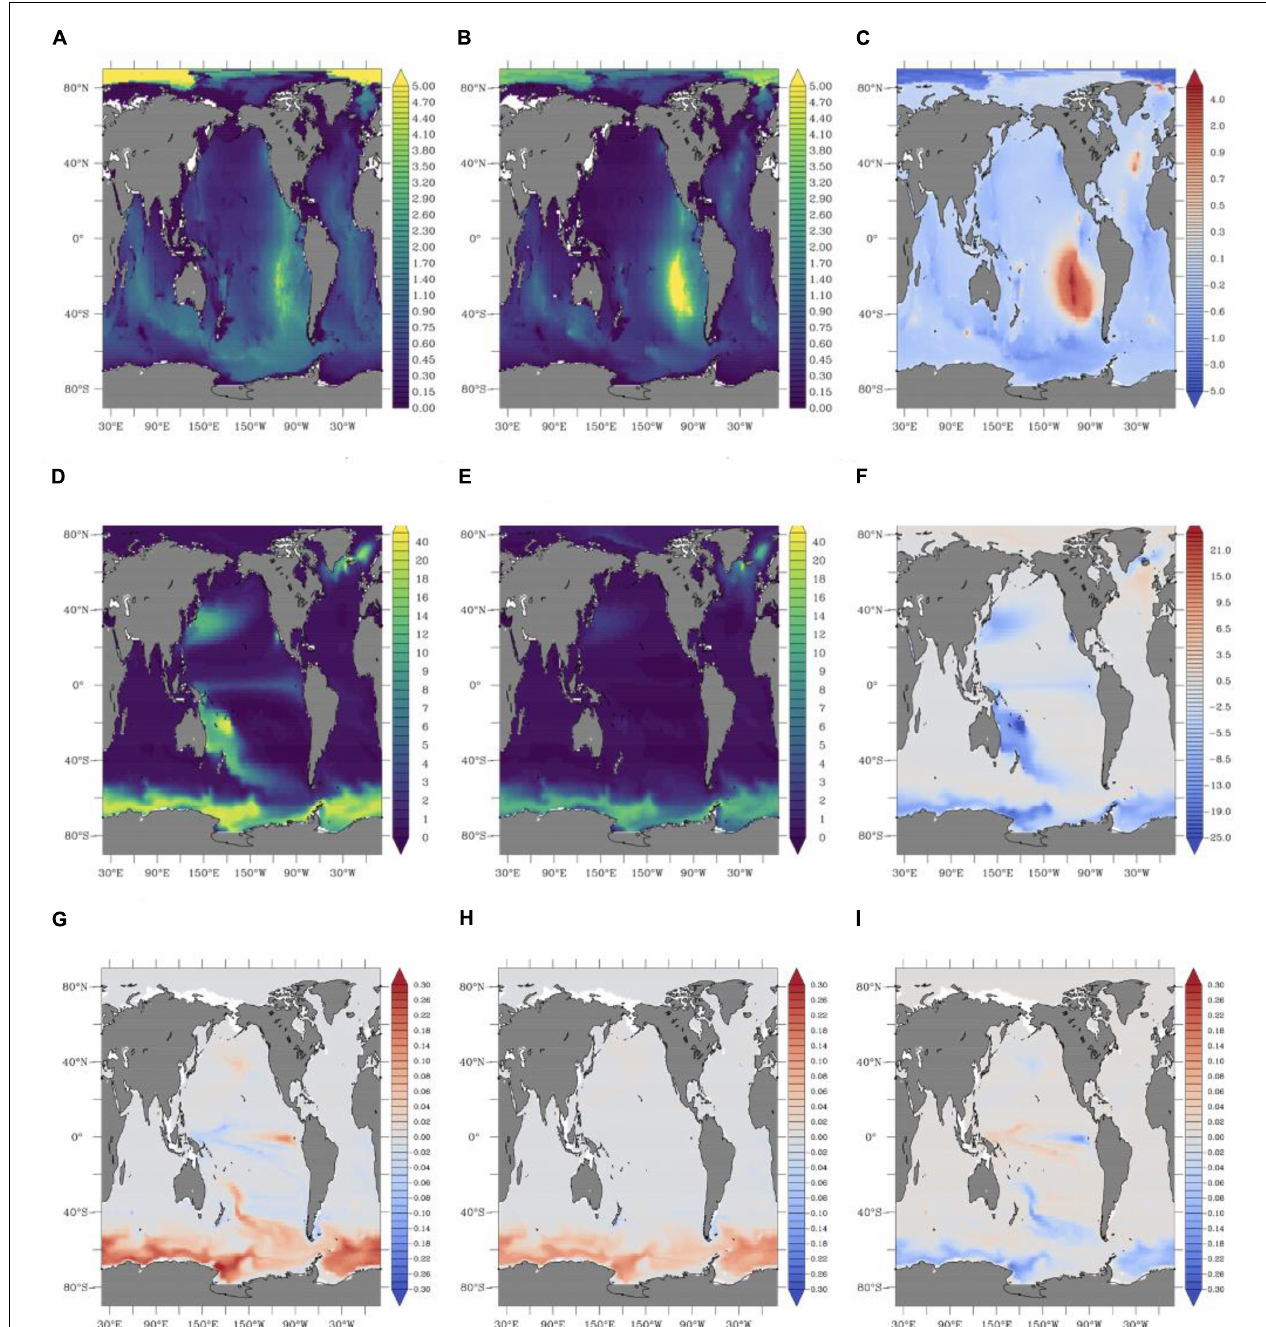
FIGURE 2 | The impact of hydrothermal vents on the concentration of dissolved iron over the full water column (in mmol m − 2 , evaluated as the difference between each experiment and the run with no hydrothermal Fe input) for (A) spreading and (B) inverse hydrothermal input experiments and (C) difference between inverse and spreading experiments, the impact of hydrothermal vents on the concentration of dissolved iron over the upper 200 m (in µ mol m − 2 ) for (D) spreading and (E) inverse hydrothermal input and (F) difference between inverse and spreading , and the impact of hydrothermal Fe on the biological carbon pump at 100 m (mol C m − 2 yr − 1 ) for (G) spreading and (H) inverse hydrothermal input experiments and (I) difference between inverse and spreading .